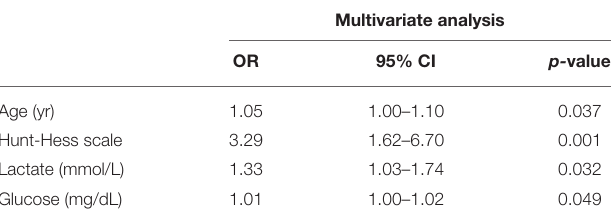
level of serum lactate above 2.3 demonstrated high